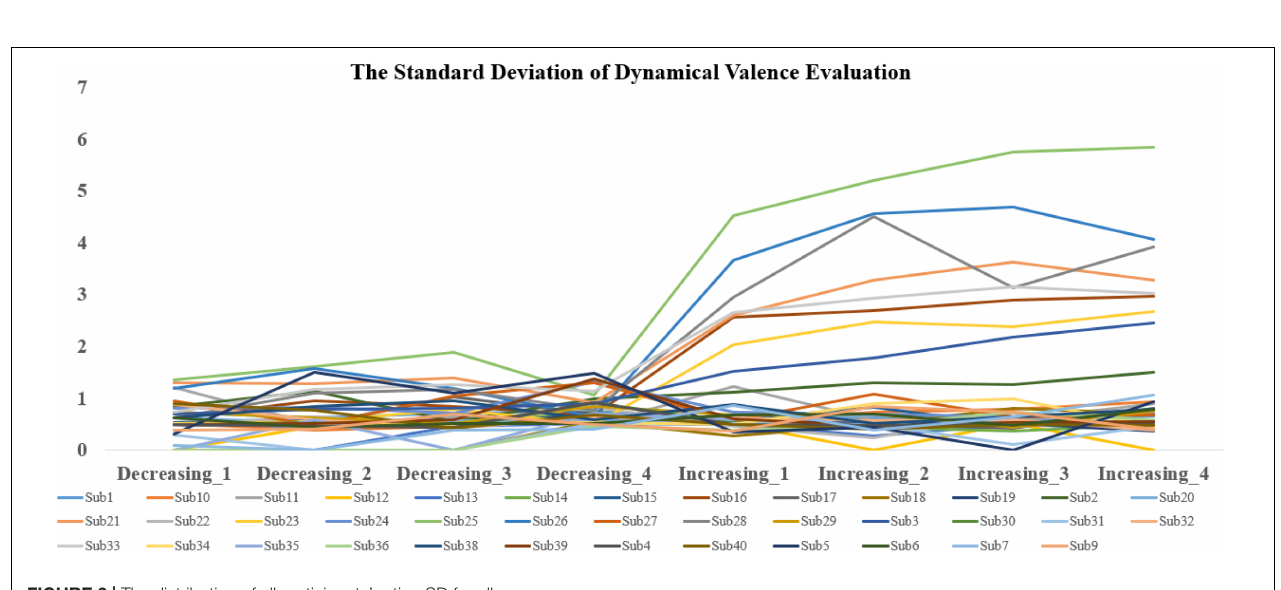
FIGURE 3 | The distribution of all participants’ rating SD for all songs.